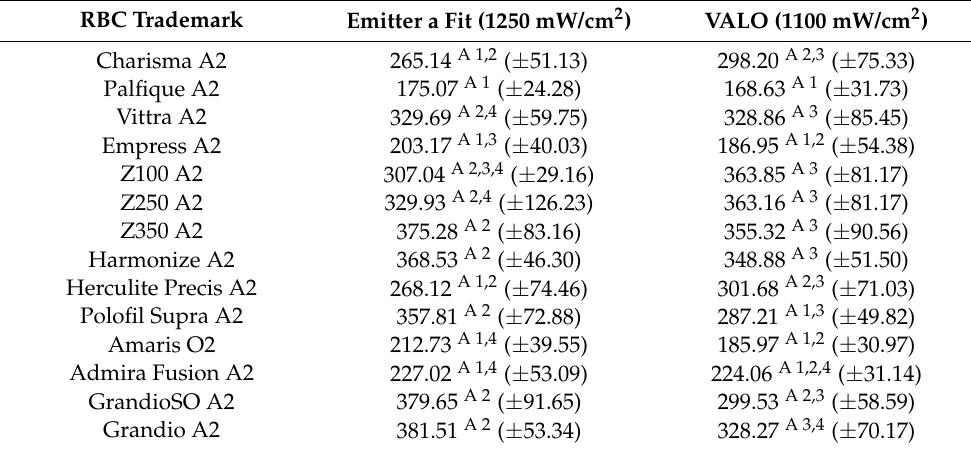
Table 4. Mean and standard deviation of the biaxial flexure strength tests (in N) of each resin-based composite (shade A2) using LEDs from second- and third-generation curing units.